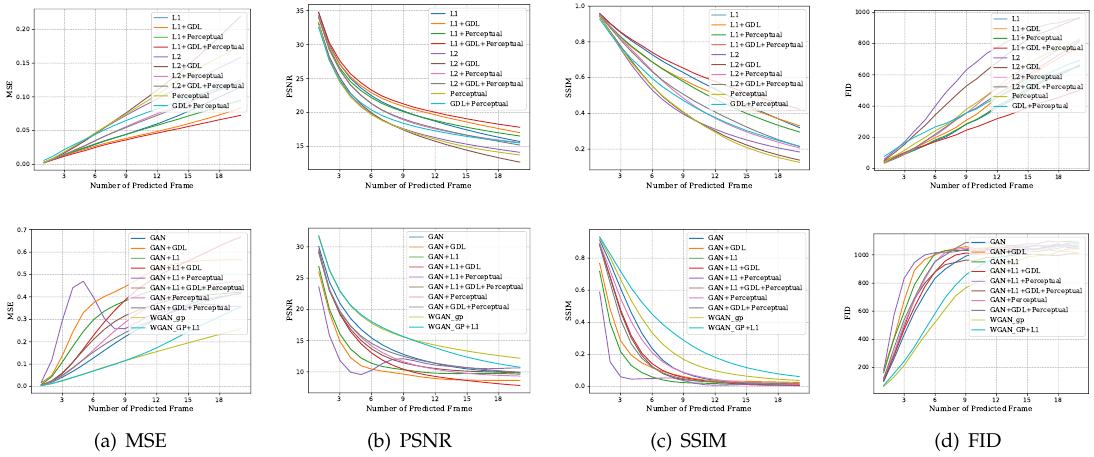
Figure A3. Mean values per predicted frame for the UA-DETRAC evaluation dataset. (MSE and FID: smaller values are better, PSNR and SSIM: larger values are